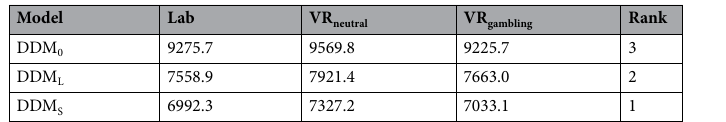
Table 4. Summary of the DICs of all DDM models in all sessions. Ranks are based on the lowest DIC in all